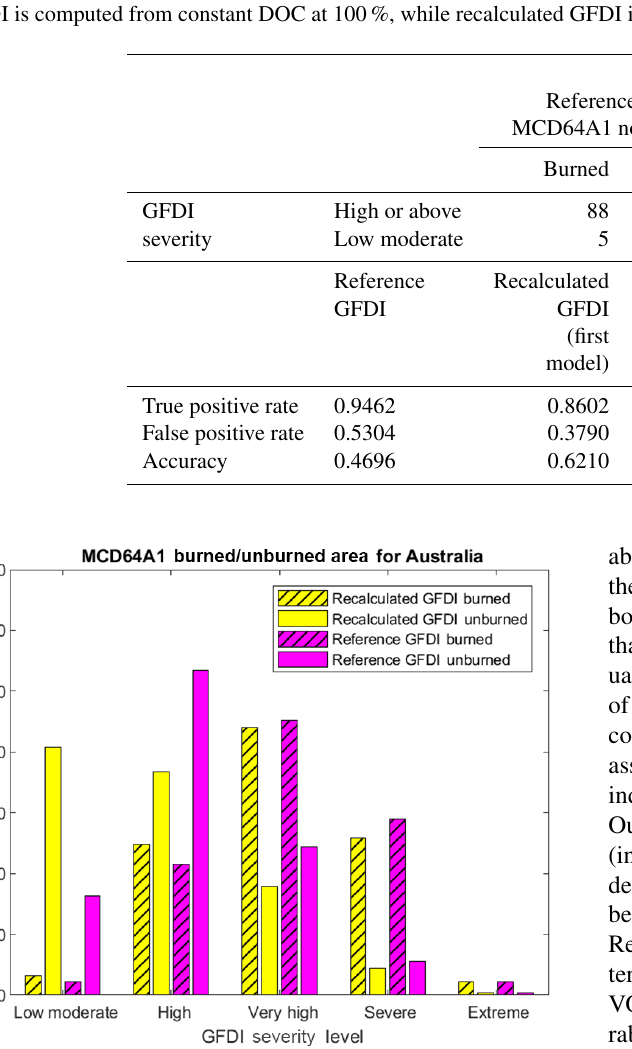
Table 3. Referenced and recalculated Grassland Fire Danger Index (GFDI) severity and burned–unburned area contingency table for satellite- based degree of curing (DOC) derived from vegetation optical depth (VOD) and normalised difference vegetation index (NDVI). Reference GFDI is computed from constant DOC at 100%, while recalculated GFDI is computed from satellite-based DOC.